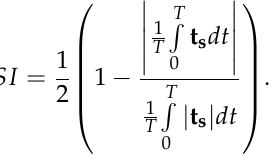
Table 2. The hemodynamic key indicators for normal, calcified, and AVNeo computational models.